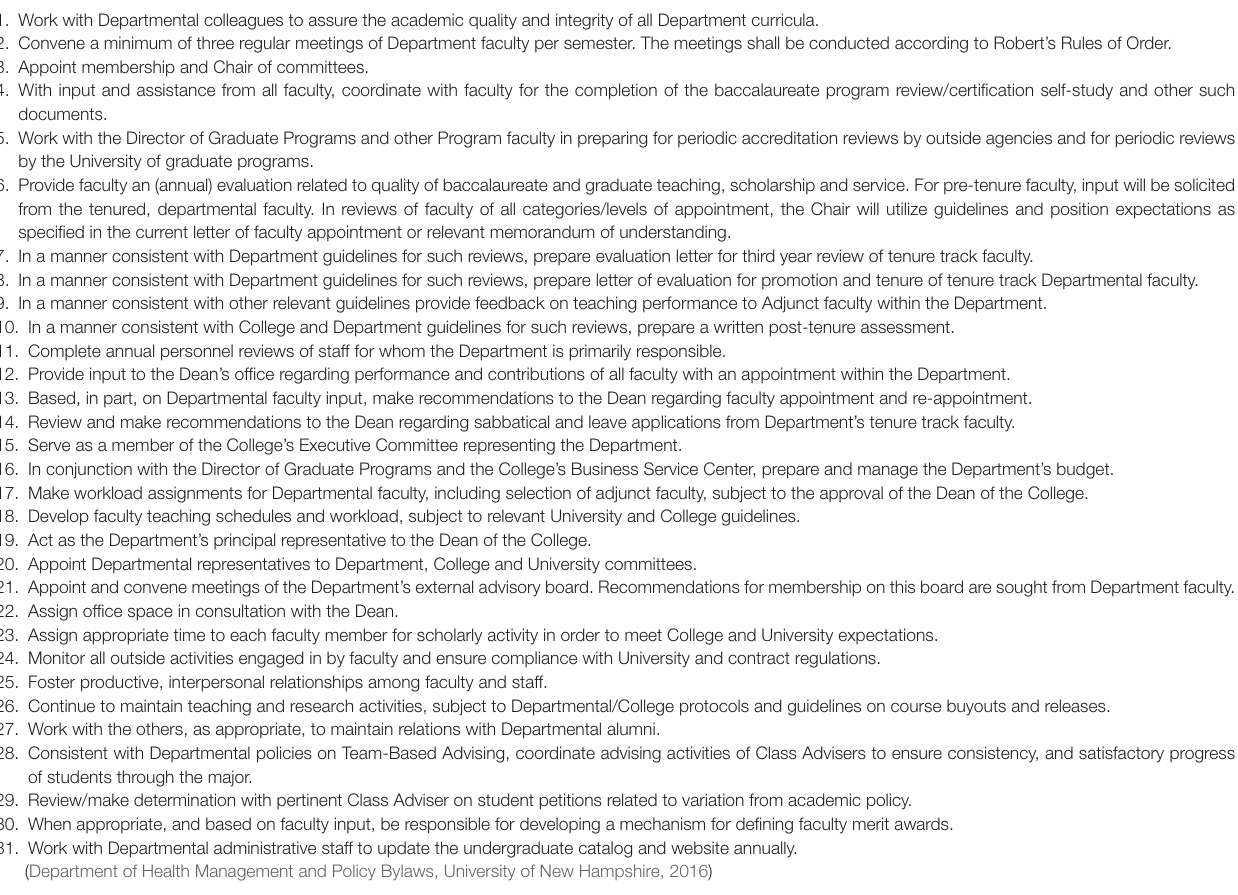
TABLE 1 | Representative duties and responsibilities of the Department